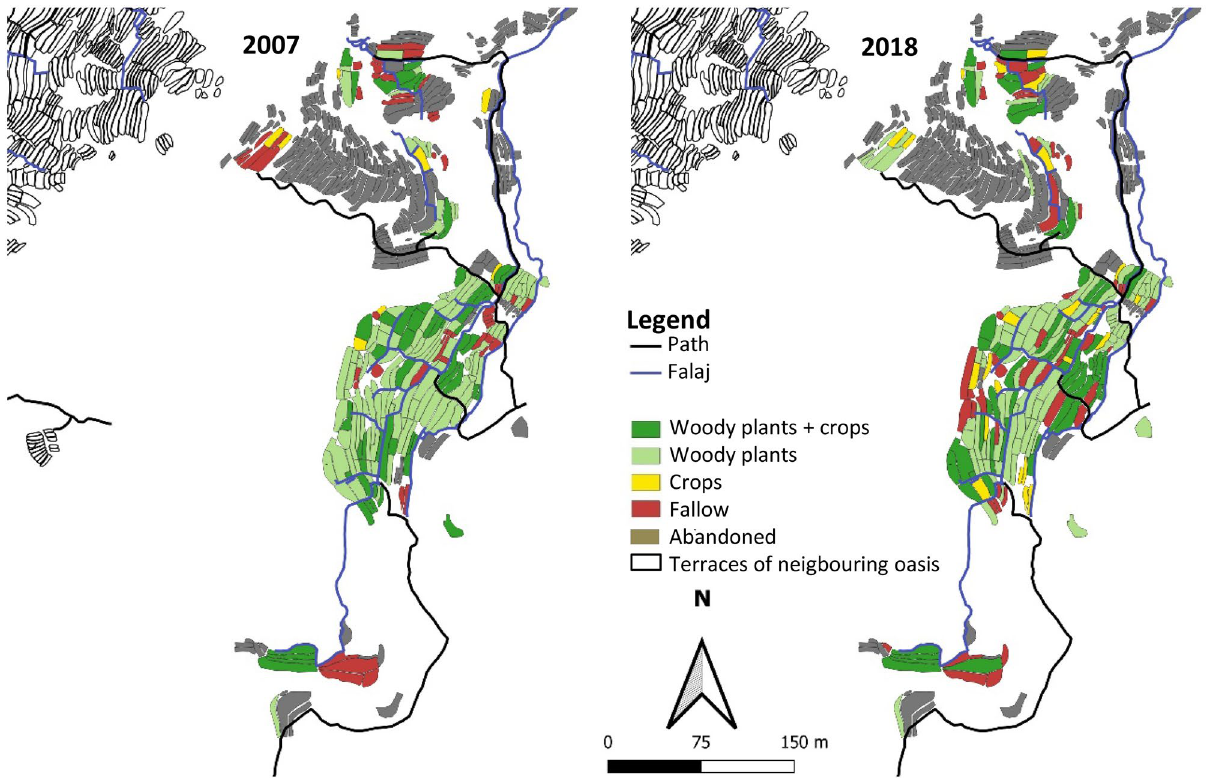
Figure 8. Landuse map of the oasis Qasha’ (1640 m a.s.l.) in Wadi Muaydin (Al Jabal Al Akhdar, Oman) in 2007 and